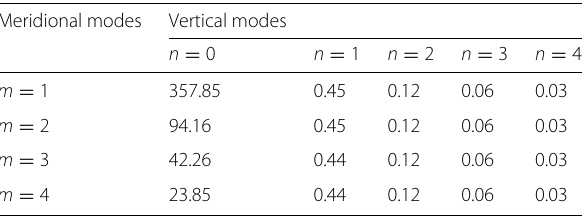
Table 1 Westward propagation speeds (cm s − 1 ) of the Rossby waves, i.e., c mn , with respect to the barotropic/baroclinic vertical ( n ) and meridional ( m ) modes Meridional modes Vertical modes n = 0 n = 1 n = 2 n =